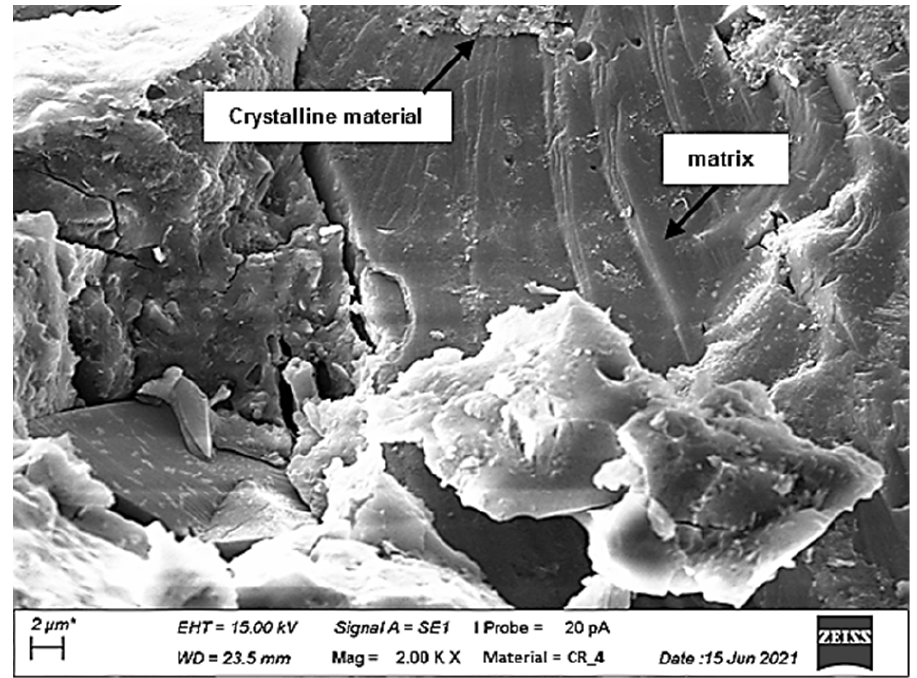
Figure 12. SEM image of the fracture surface of the mixed rubble geopolymer at 2000 × magnification.